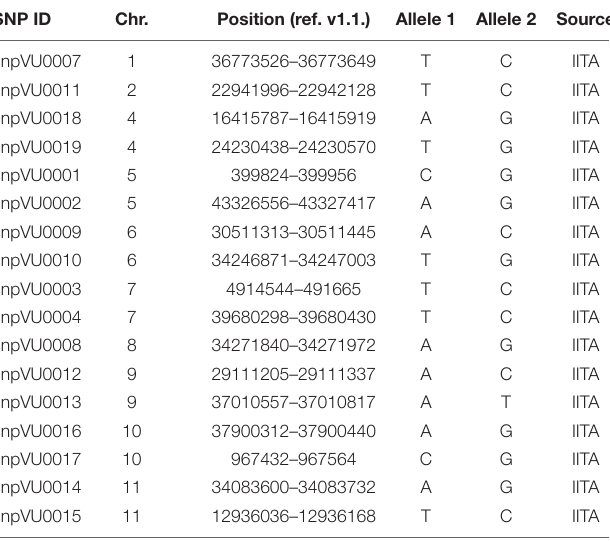
TABLE 2 | Quality control (QC) Kompetitive Allele-Specific PCR (KASP) markers used for hybridity test. SNP ID Chr. Position (ref.